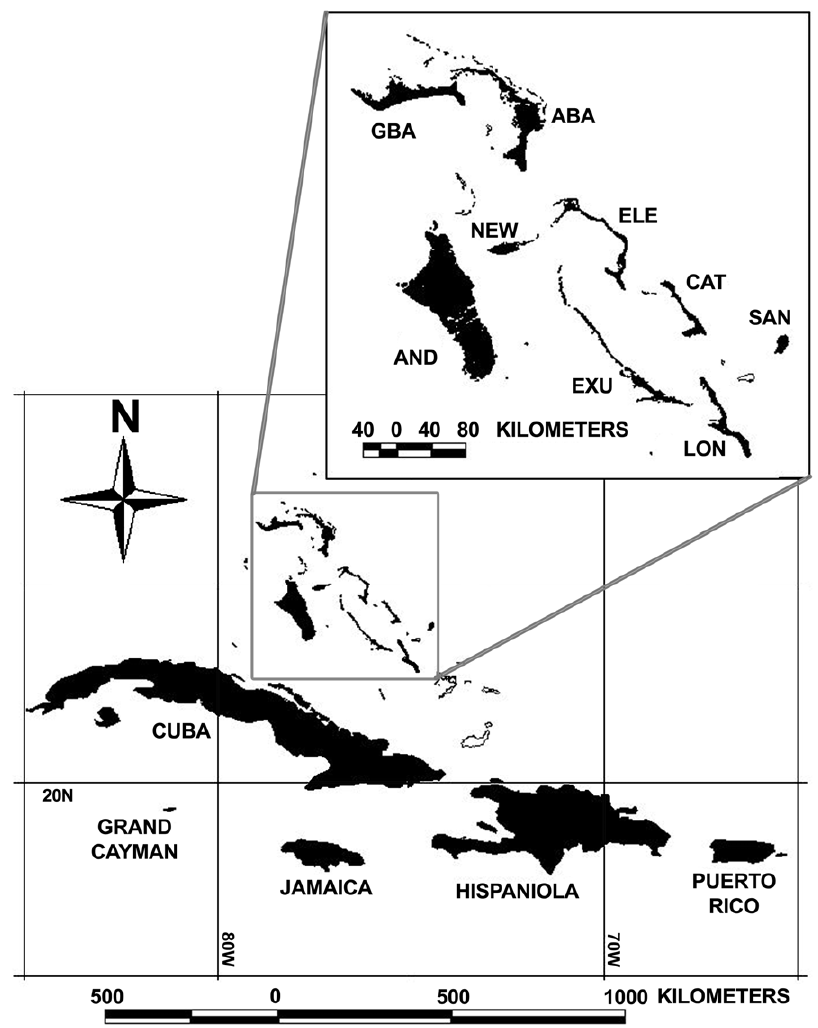
Figure 1. Map of the study area. Sampled islands are shown in black. Inset shows the Bahamas: ABA=Abaco, AND=Andros, CAT=Cat Island, ELE=Eleuthera, EXU=Exuma, GBA=Grand Bahama, LON=Long Island, NEW=New Providence and SAN=San Salvador. Erophylla was sampled on ABA, AND, CAT, Cuba, GBA, ELE, EXU, Hispaniola, Jamaica, LON, NEW, Puerto Rico, and SAN. M. waterhousii was sampled on ABA, CAT, Cuba, EXU, Grand Cayman, Hispaniola, Jamaica, and LON.